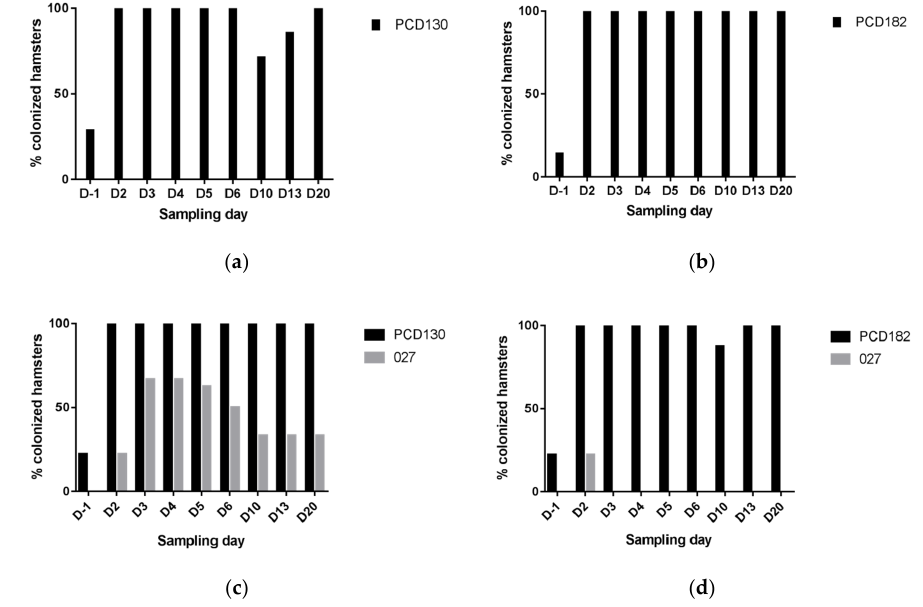
Figure 5. Colonization rates among surviving hamsters in the PCD130 ( a ), PCD182 ( b ), PCD130 + 027 ( c ), and PCD182 + 027 ( d ) groups (respectively B, C, D and E).